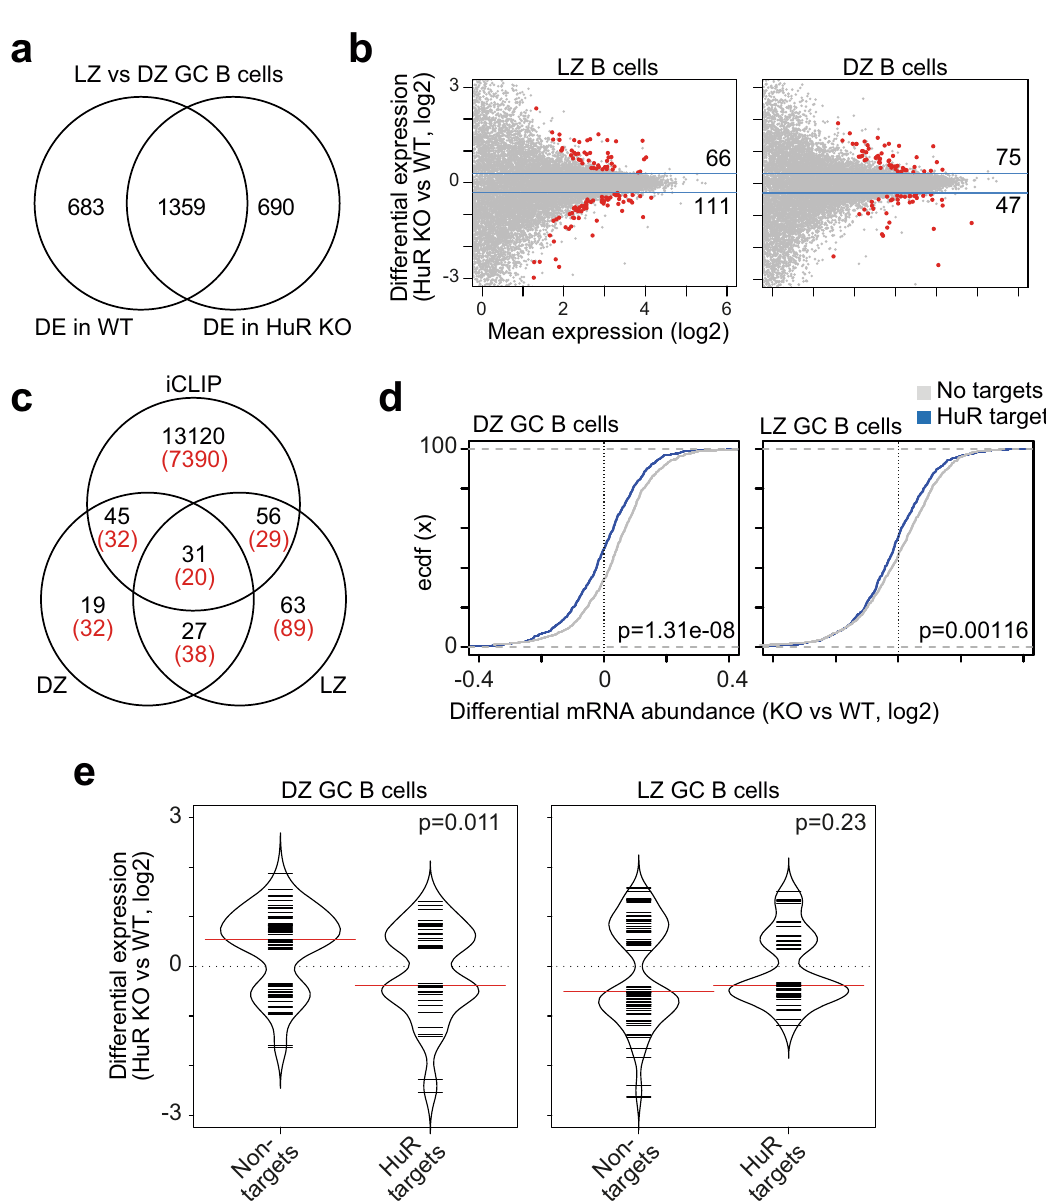
Fig. 5 Transcriptomics identity of DZ and LZ GC B cells is controlled by HuR. a Venn diagram showing the overlap of genes that are differentially expressed (DE) between LZ and DZ GC B cells in HuR fl / fl (control = WT) and HuR fl / fl AID Cre (HuR KO) mice (DESeq2, BH correction, FDR < 0.05). b MA plots with DE genes identi fi ed in HuR KO LZ and HuR KO DZ GC B cells compared to control cells. c Venn diagram showing the overlap of DE genes in HuR KO LZ, HuR KO DZ GC B cells and genes of which mRNA transcripts were identi fi ed as targets of HuR by iCLIP (in black — number of genes identi fi ed as targets of HuR in LPS-stimulated B cells and with at least one signi fi cant crosslink, BH correction, FDR < 0.05; in red — genes identi fi ed as HuR targets in all conditions of B cells treated with LPS, α CD40 + IL4 or α IgM + IL4). d Cumulative distribution of differential mRNA abundance in DZ KO and LZ GC KO GC B cells compared to WT cells of HuR mRNA targets and mRNAs not bound by HuR. All mRNA transcripts were merged by gene and subsequently subdivided into targets of HuR or not upon integration of HuR iCLIP data from LPS-stimulated B cells (HuR binding de fi ned as annotation of at least fi ve unique cDNA counts per x-link site in the 3 ’ UTR). Data are from the top 25% of most expressed genes (Kolmogorov – Smirnov test). e Bean plot of DE genes in HuR KO DZ GC B cells (left panel) and HuR KO LZ GC B cells (right panel) compared to control WT cells and clustered based on the binding of HuR to their RNA transcripts (minimum 5 unique cDNA counts annotated per x-link site by iCLIP and FDR < 0.05, Kolmogorov – Smirnov